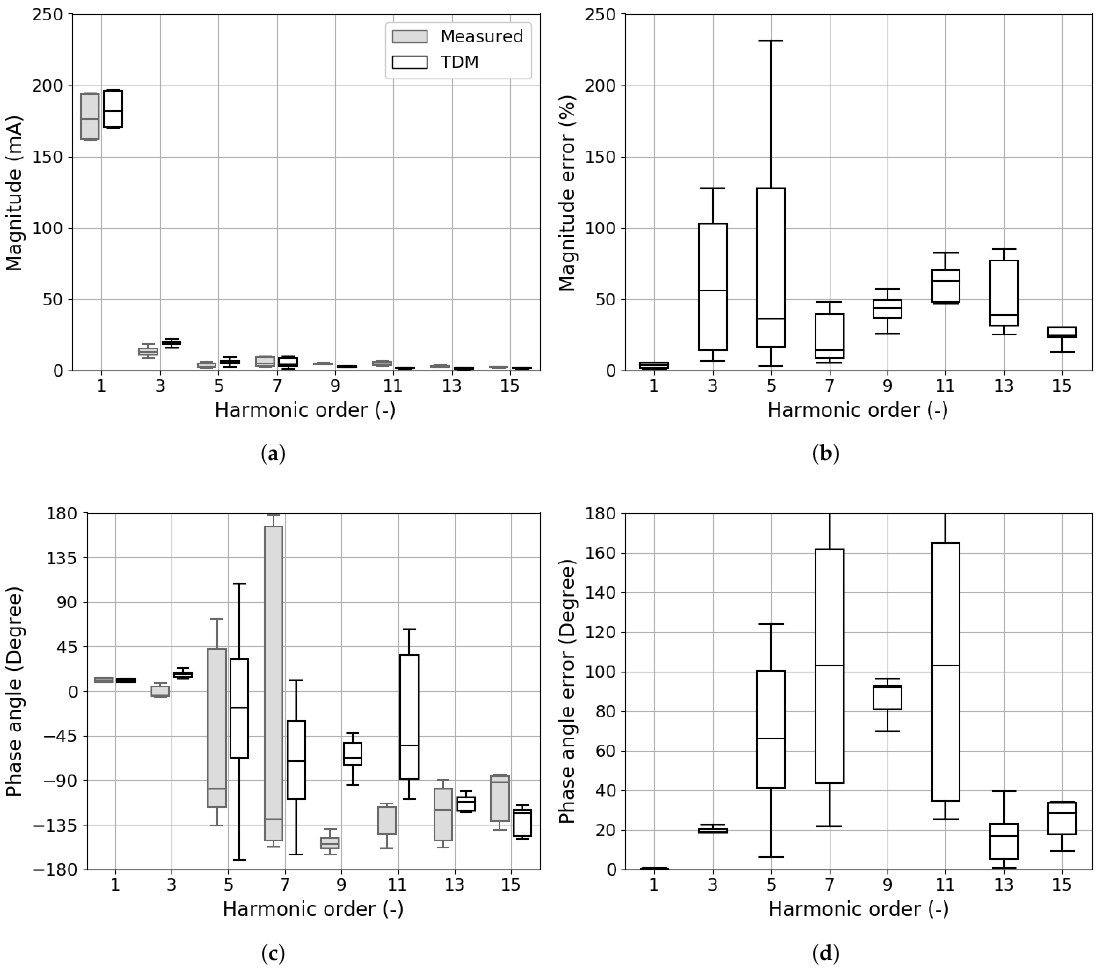
Figure 7. LED Type D: Comparison of the time-domain model (TDM) and the measured data for all test points: ( a ) Magnitude; ( b ) Magnitude error; ( c ) Phase angle; and ( d ) Phase angle